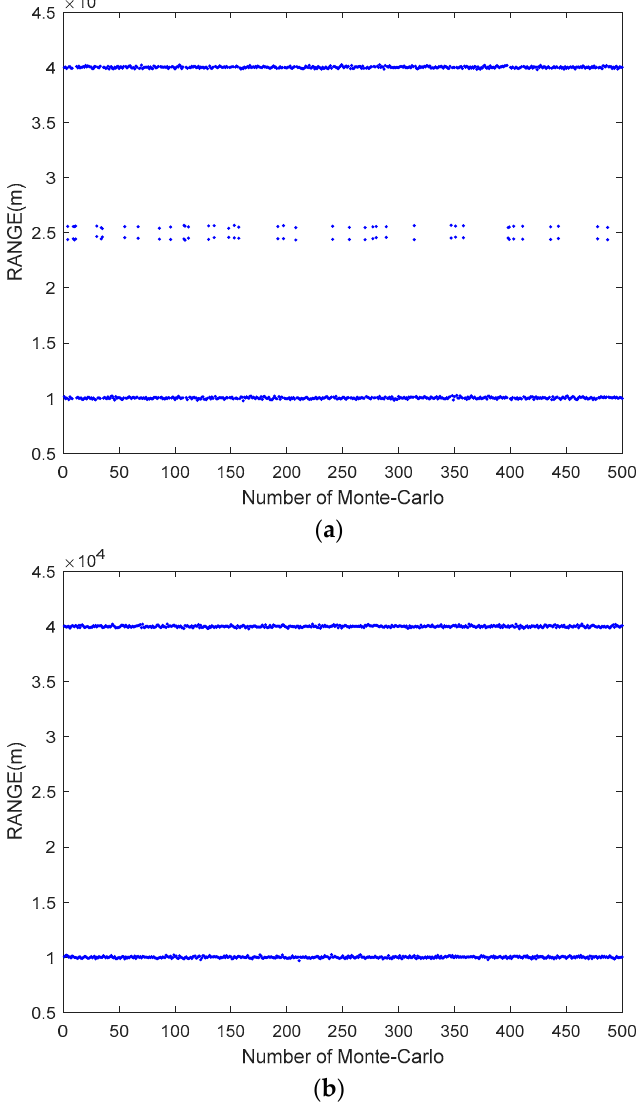
Figure 3. The range estimation results obtained by the proposed algorithm with unpairing and pairing. ( a ) Unpaired range estimation; ( b ) paired range estimation.